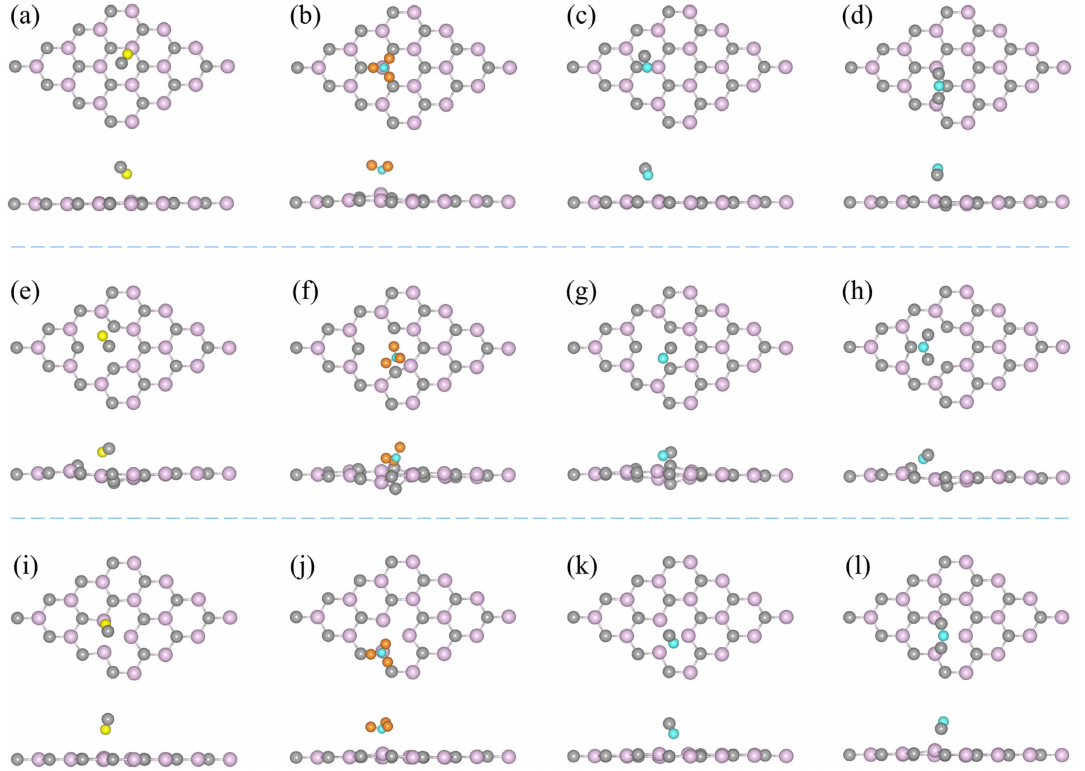
Figure 2. The stable structures of ( a ) CO, ( b ) NH 3 , ( c ) NO, or ( d ) NO 2 adsorbed on intrinsic g − ZnO systems, ( e – h ) V Zn /g − ZnO systems, and ( i – l ) V O /g − ZnO systems. The pink, grey, yellow, orange, and blue balls represent Zn, O, C, H, and N atoms, respectively.